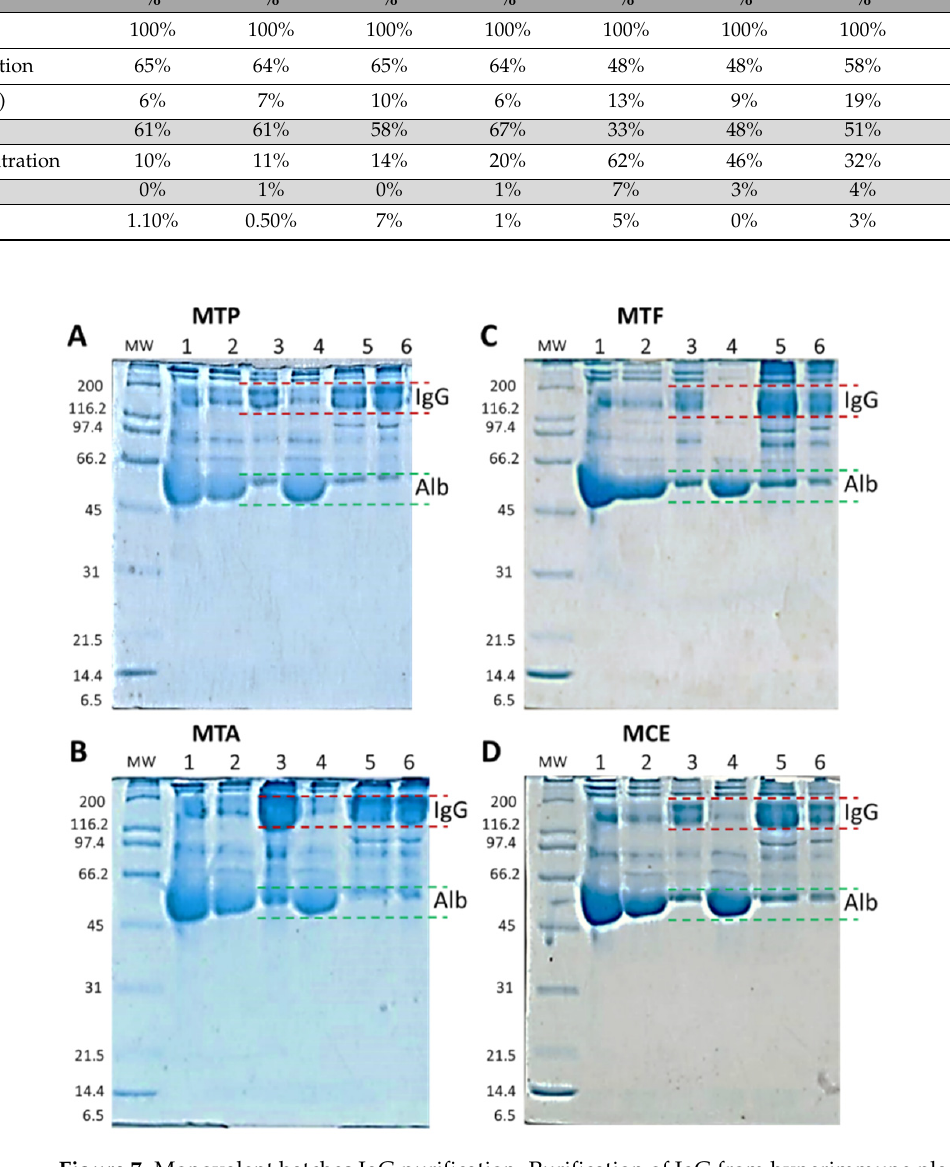
Figure 7. Monovalent batches IgG purification. Purification of IgG from hyperimmune plasma from ( A ) Tityus pachyurus monovalent batch (MTP); ( B ) Tityus asthenes monovalent batch (M.T.A.); ( C ) Tityus fuhrmanni monovalent batch (M.T.F.); ( D ) Centruroides spp. monovalent batch (M.C.E.). 1: Plasma pool. 2: Plasma before precipitation. 3: Precipitate (Biomass). 4: Filtrate. 5: